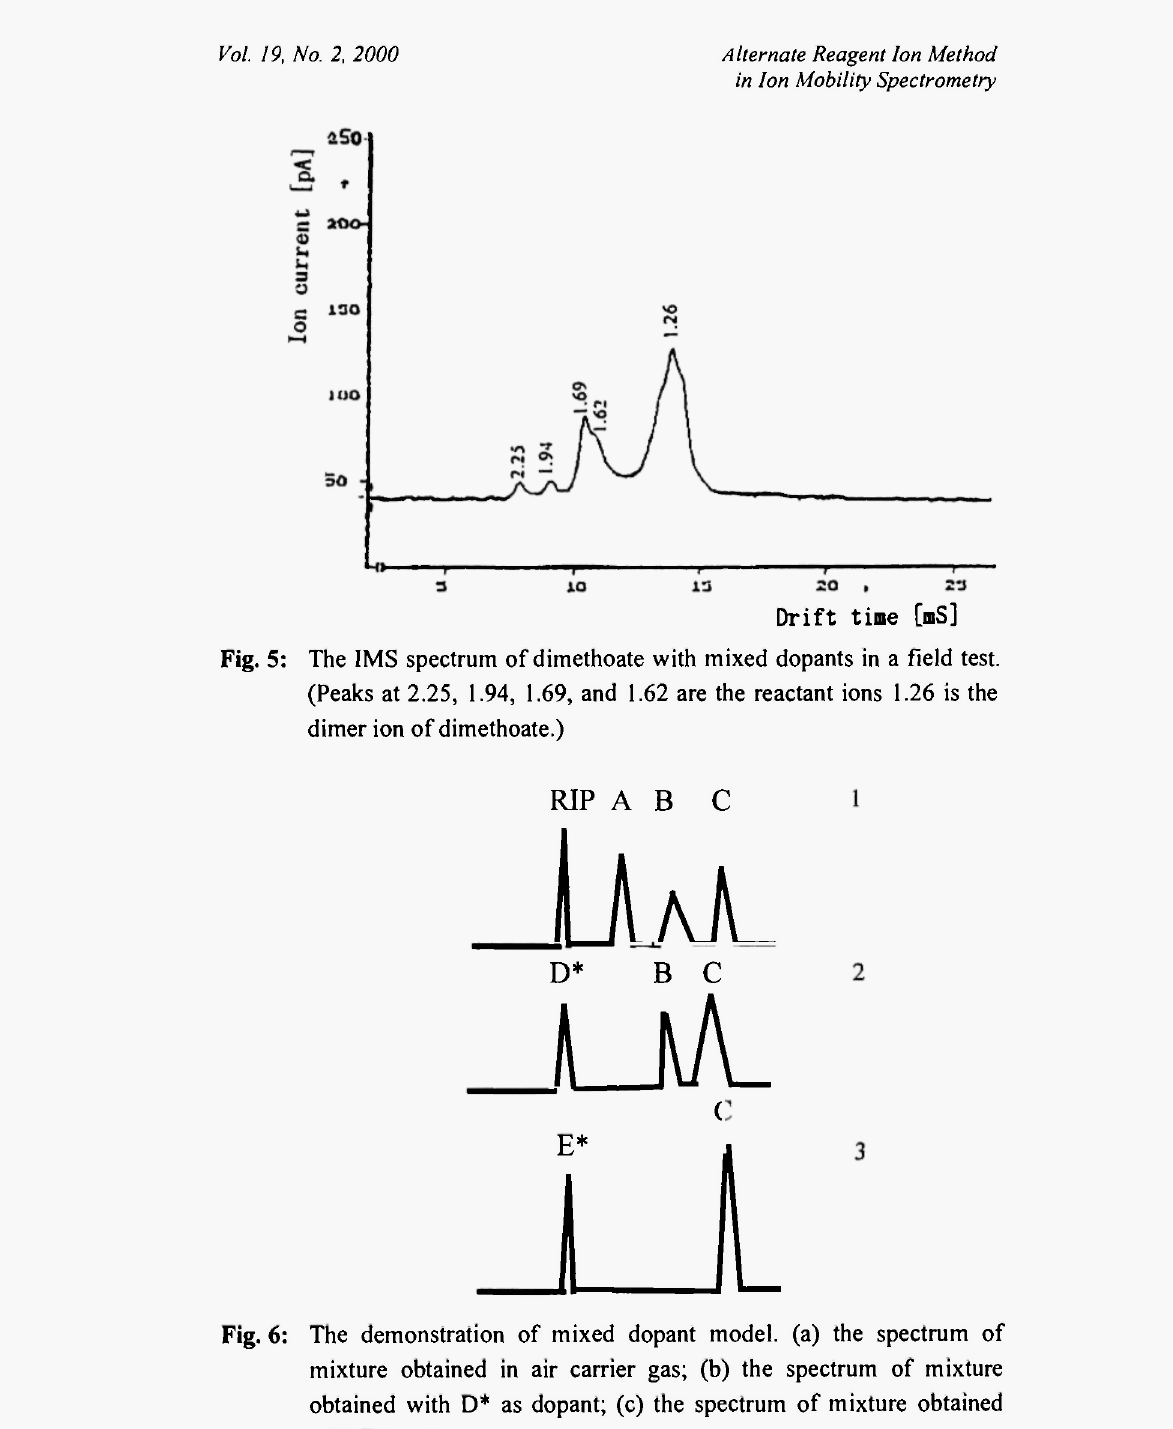
Fig. 6: The demonstration of mixed dopant model, (a) the spectrum of mixture obtained in air carrier gas; (b) the spectrum of mixture obtained with D* as dopant; (c) the spectrum of mixture obtained with E* as